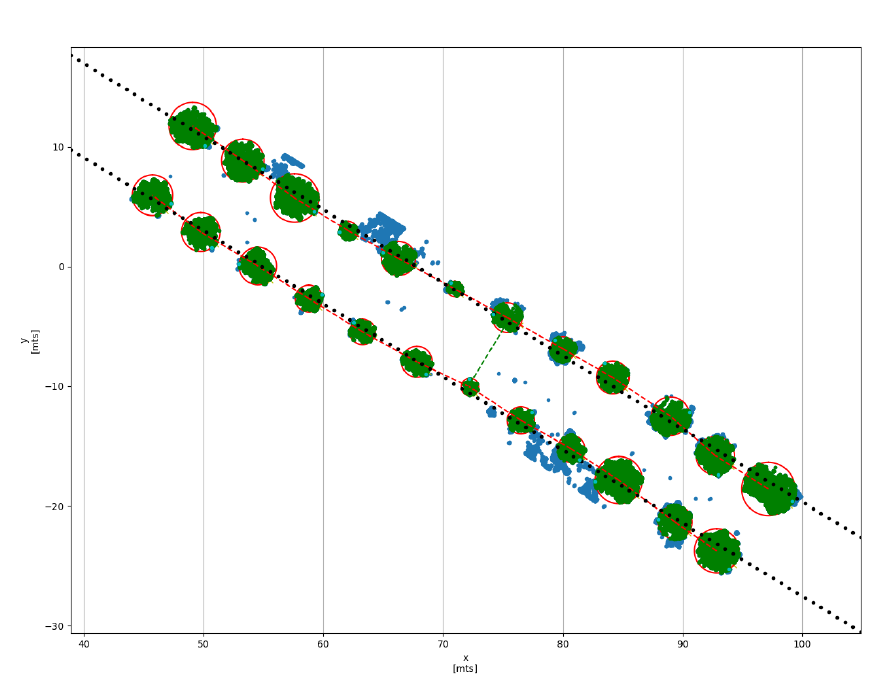
Figure 12. Assisted measurement of crop parameters from the top view of the point cloud with a ground removing in the interactive Python